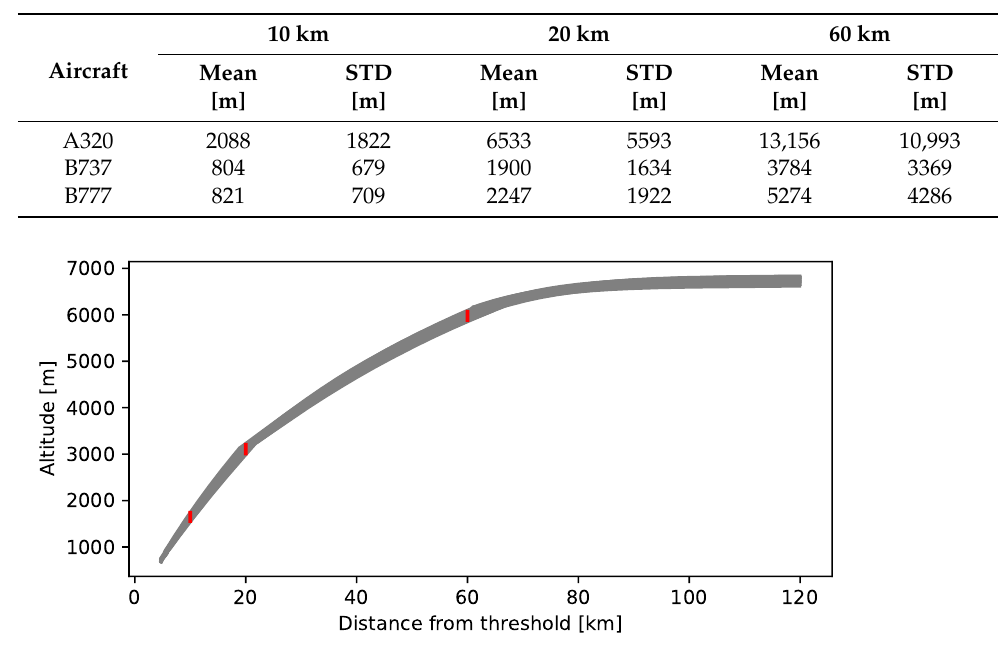
Figure 7. Aggregated plot from the vertical departure profiles in 23 wind scenarios (grey) and distance dependent heights of gates of the optimized funnels for A320-211, 58,000 kg only. Maximum altitude difference is 270 m at 20 km from